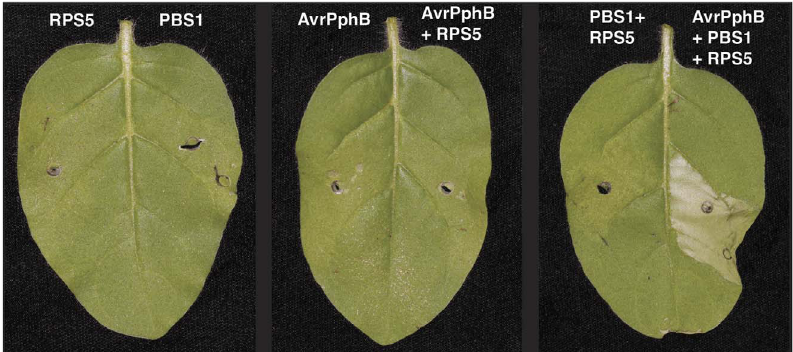
Figure 1. Reconstituting the RPS5 -mediated defense pathway in N. glutinosa . The left and right side of each leaf were transiently transformed with the gene(s) listed above each image. Leaves were detached and photographed 24 hours after dexamethasone induction.